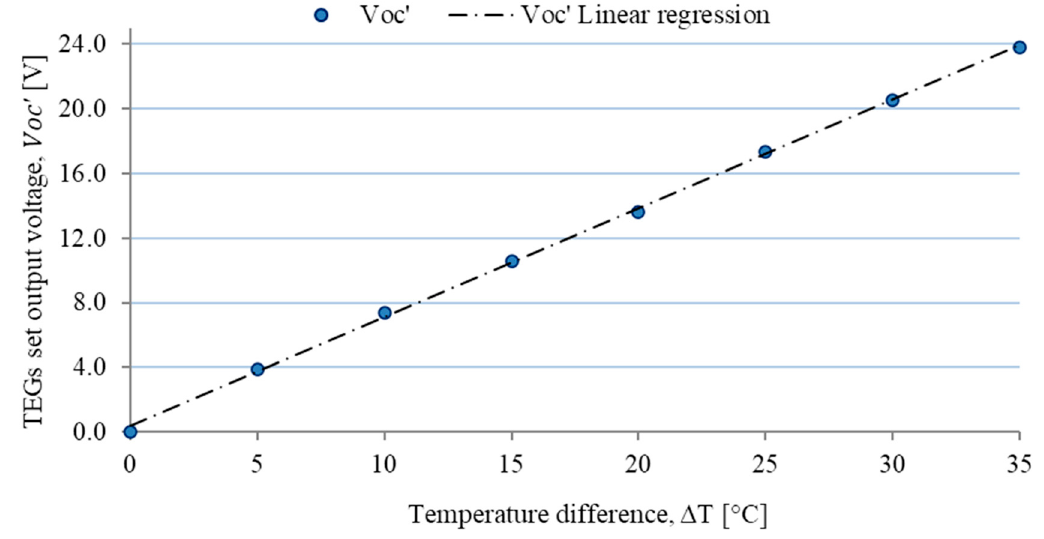
Figure 7. Open circuit voltage of inbC1-127.08HTS TEGs set as a function of temperature difference.